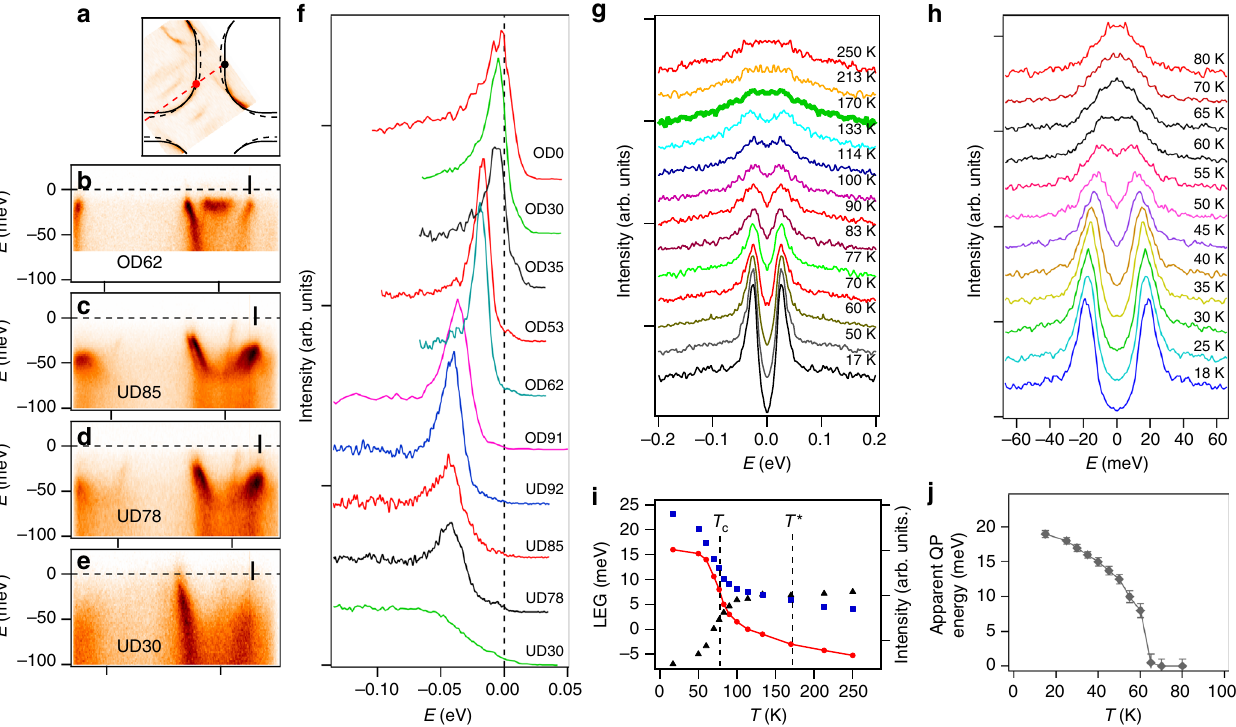
Fig. 2 Spectral gap from the anti-nodal region of Bi 2 Sr 2 CaCu 2 O 8 + δ . a Fermi surface of the UD85 sample, with the dashed red line indicating the momentum line that is probed in b – e for samples with different oxygen content. b – e ARPES intensity as a function of binding energy and momentum along the dashed line in a , taken at T = 12 K, for several different doping levels, as indicated. f The EDC curves taken at the Fermi wave-vector of the bonding state from the anti-nodal region of the Fermi surface, as indicated by bars in b – e . g Temperature dependence of ARPES spectra for the underdoped sample, UD78, ( T c = 78 K) and h for the overdoped sample, OD62 ( T c = 62 K). The spectra in g and h are taken at k F marked with red and black dots in a , respectively. Spectra in g , h are symmetrized relative to the Fermi level. i , j Temperature dependence of several spectral parameters for the two samples shown in g , h : intensity at the Fermi level (black triangles) and at the peak energy (blue squares), Leading edge gap (LEG) of non-symmetrized spectra (red circles) and apparent quasiparticle peak position (gray diamonds). The error bars in j correspond to the fi tting uncertainties in the apparent quasiparticle peak positions from